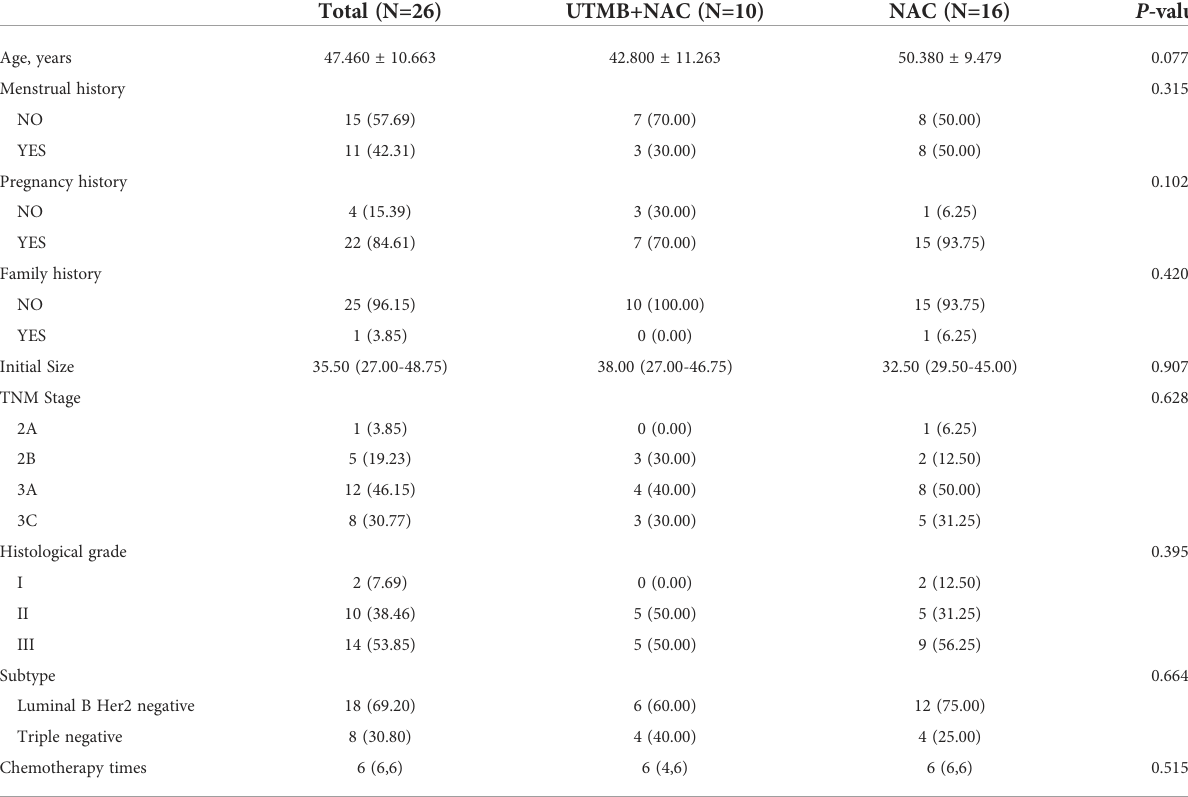
TABLE 1 Baseline characteristics of